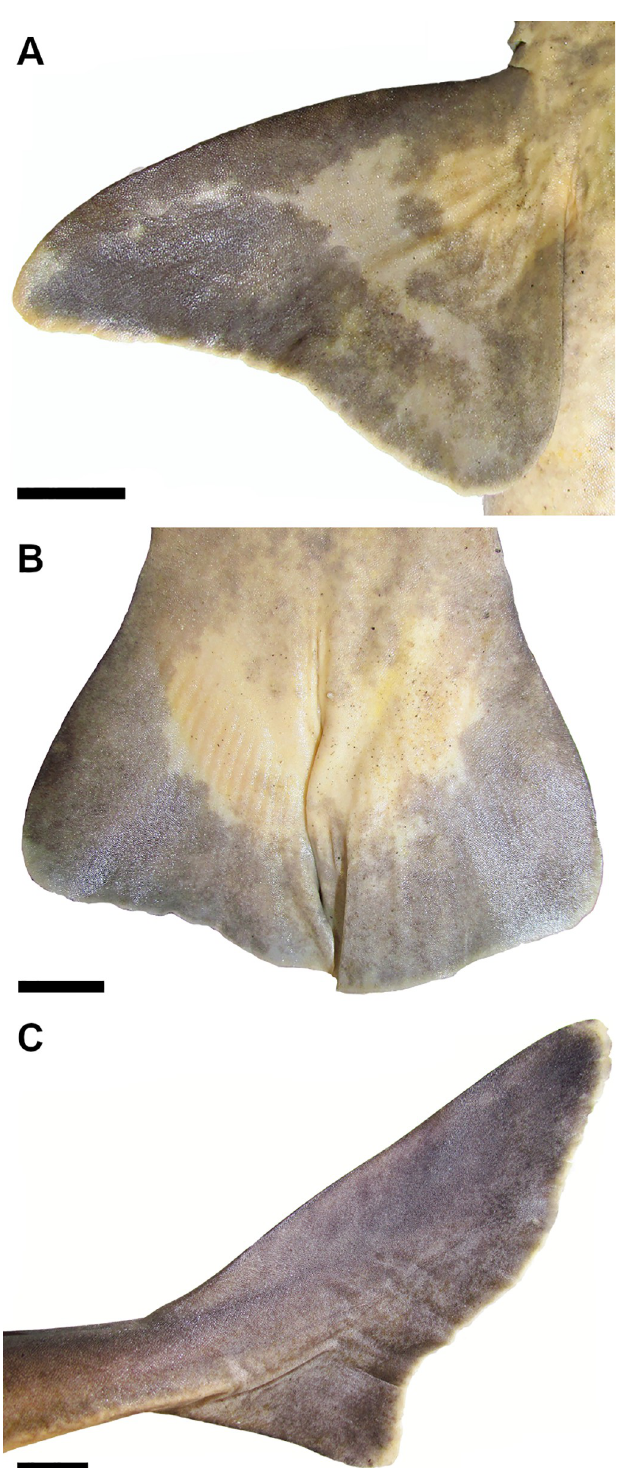
Fig 19. Pectoral (A), pelvic (B) and caudal (C) fins of the neotype of C . barbifer , HUMZ 197852, adult female, 870 mm TL. A,B: ventral view; C: lateral view. Scale bars: 20 mm.